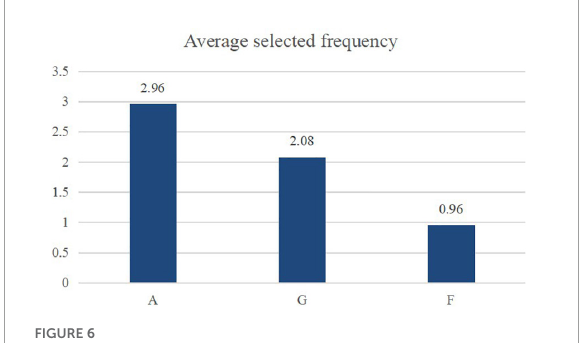
FIGURE6 Average frequency of three audio materials selected in paired